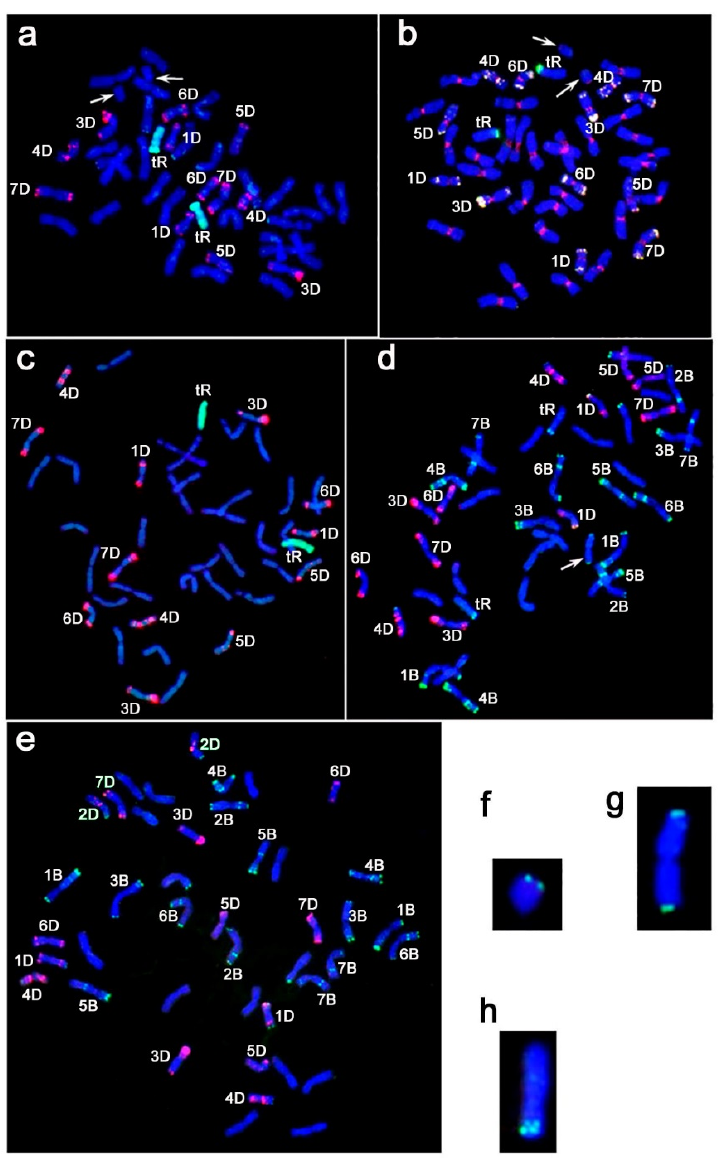
Figure 1. Fluorescence in situ hybridization (FISH) on mitotic metaphase chromosomes of the Line 808/1 plants ( a , b ); 844/4 ( c , d ) and 857 ( e ) with combinations of probes: ( a ) and ( c )—pAs1 (red) and rye DNA (green); b —pAet6-09 (red), pAwRc (green) and pAs1 (yellow); ( d ) and ( e )—pSc119.2 (green) and pAs1 (red) chromosomes are blue as a result of counterstaining with DAPI. Arrows indicate telocentric chromosomes of wheat ( a , b ) and an unpaired chromosome formed by the centric fusion of two wheat telocentrics ( d ). Separately presented: telocentric chromosomes of wheat ( f ), unpaired chromosome formed by the centric fusion of two wheat telocentrics ( g ) and telocentric chromosomes of rye ( h ). Green signals on these chromosomes indicate probe